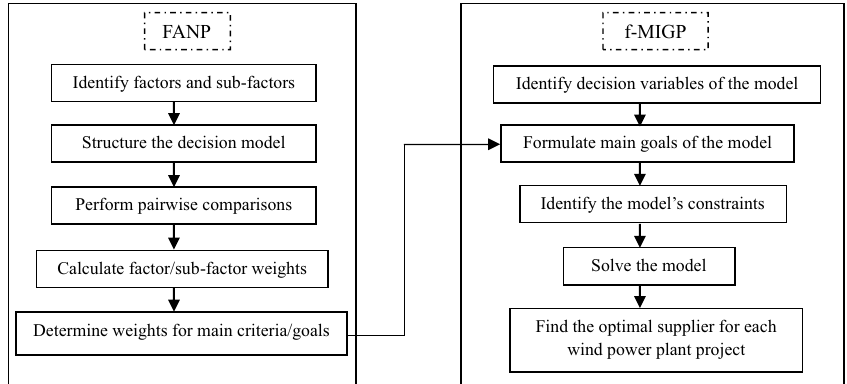
Identify decision variables of the model Formulate main goals of the model Identify the model’s constraints Solve the Find the optimal supplier for each wind power plant project